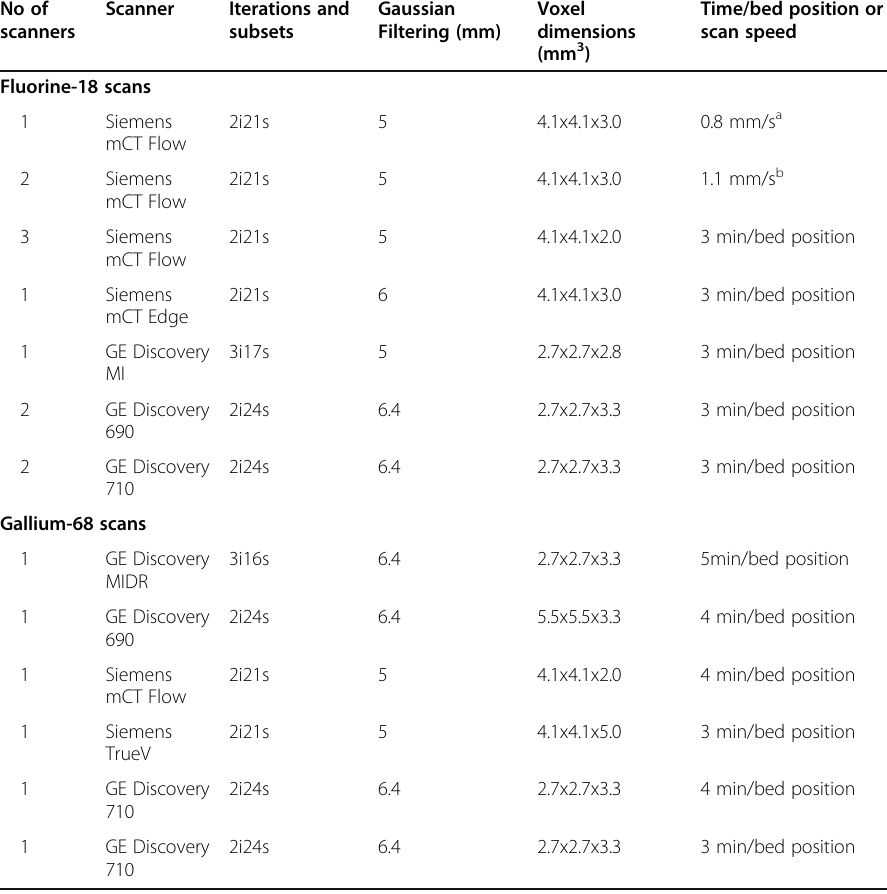
a Corresponds to 2.5 mm/bed position according to Siemens instructions for protocol definition b Corresponds to 2 mm/bed position according to Siemens instructions for protocol